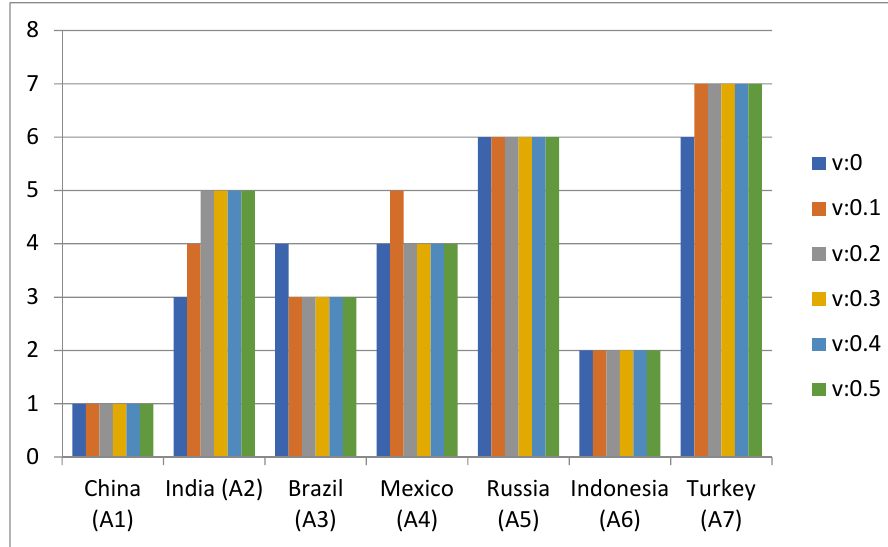
Figure 2. Ranking results for (v:0–0.5).